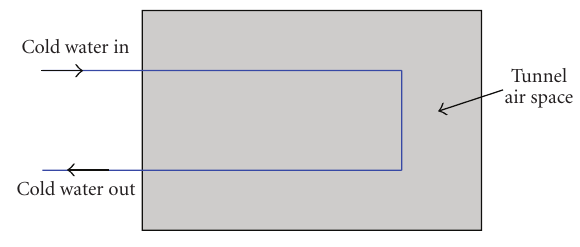
Figure 3: Initial design pipe